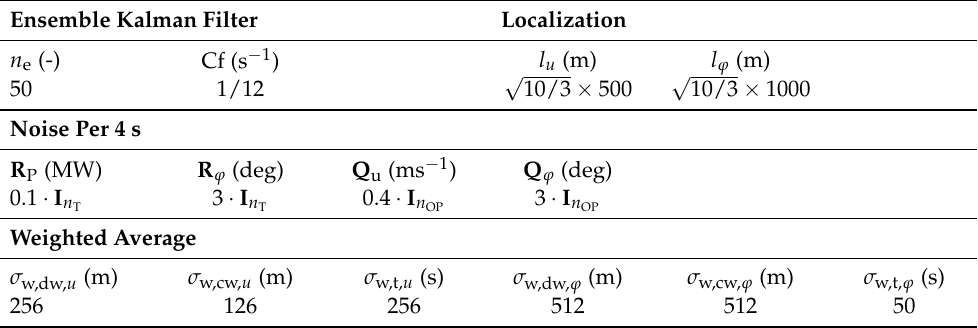
Table 1. Parameters used in the Ensemble Kalman Filter framework.